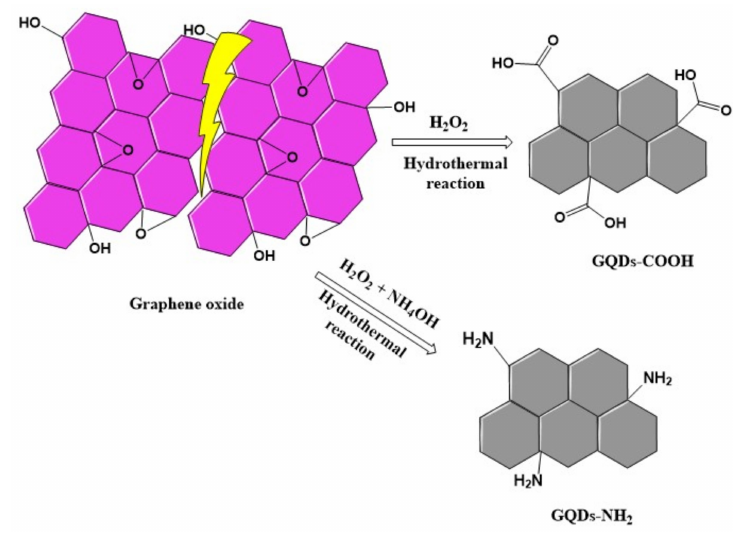
Figure 1. Illustration of the preparation of GQDs from graphene oxide.